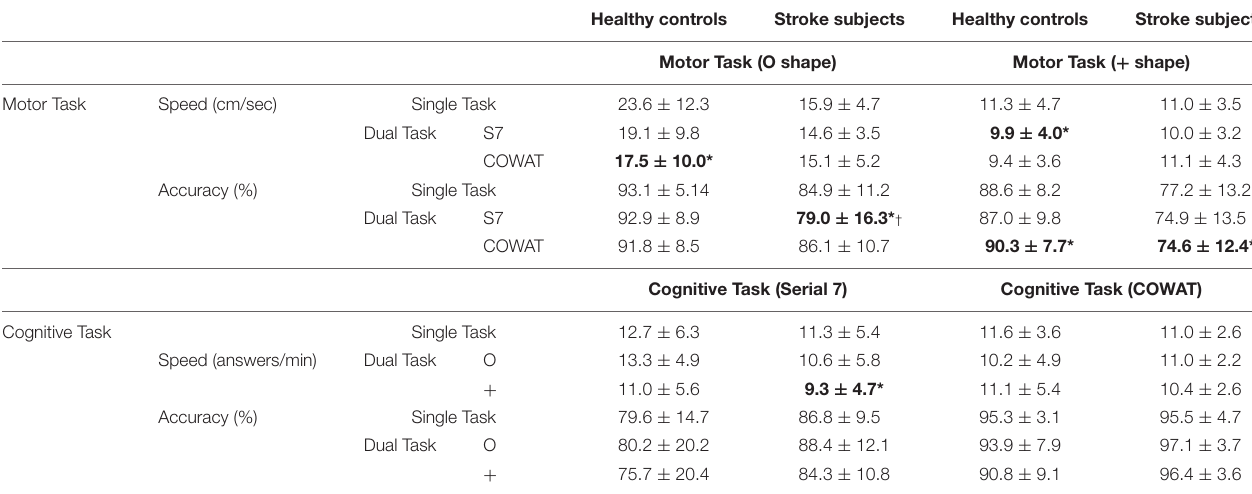
TABLE 2 | Cognitive and motor speed and accuracy in single and dual tasks between participants with stroke and healthy controls. Healthy controls Stroke subjects Healthy